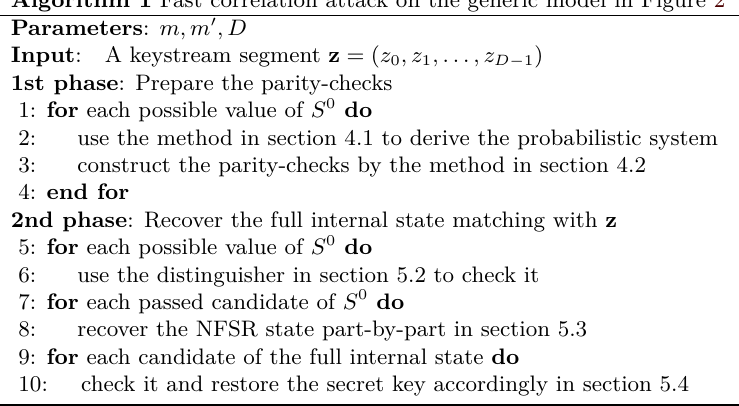
Algorithm 1 Fast correlation attack on the generic model in Figure